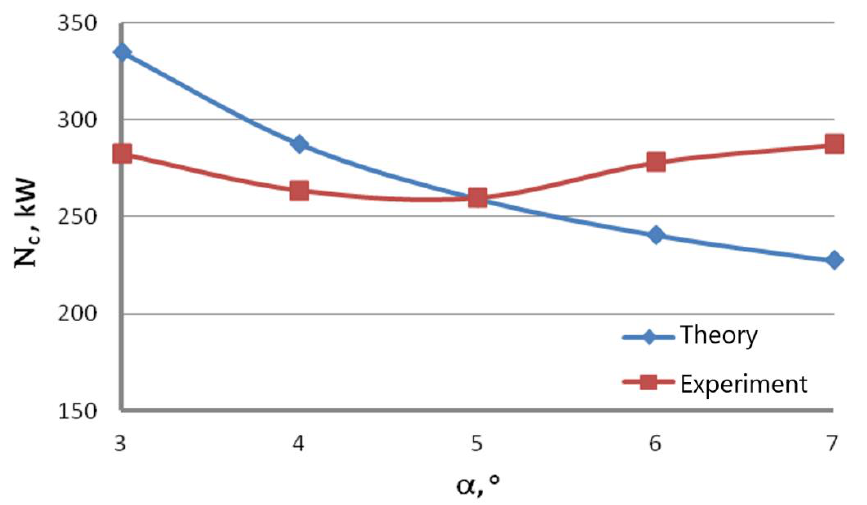
Figure 10. Change of the total drawing power, both theoretical and actual, as a function of the drawing angle for the wires drawn with the speed of 20 m/s.